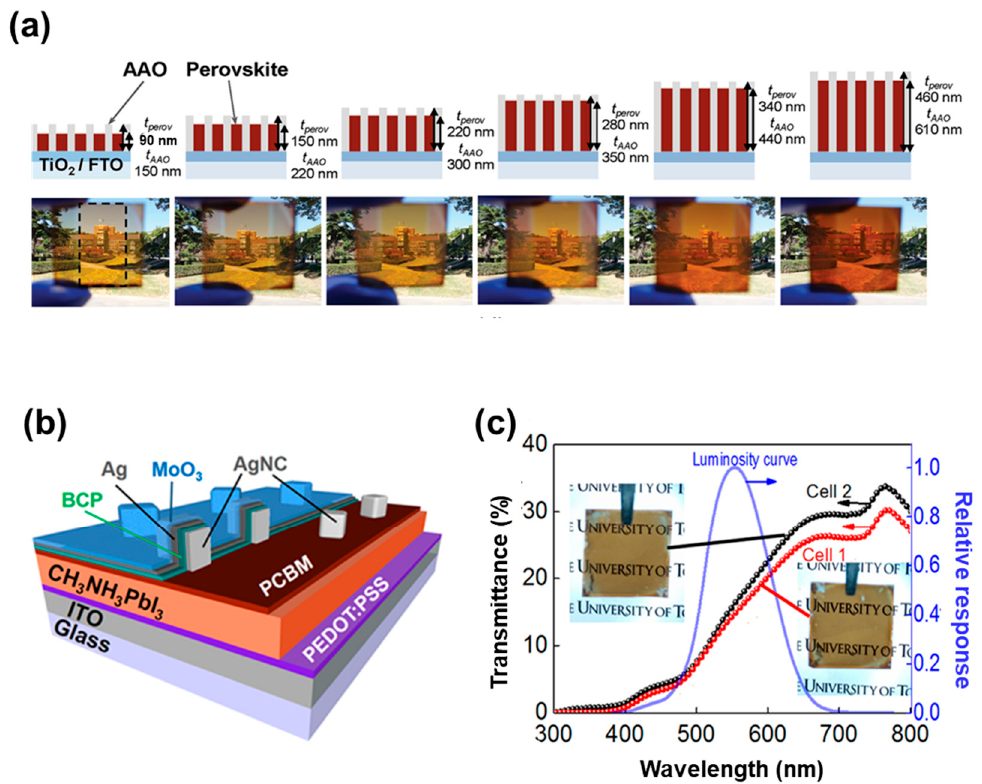
Figure 6. ( a ) Nanopillar-structured ST-PSC with different AAO templates and perovskite thicknesses. ( b ) Schematic representation of the device fabricated with Ag nanocubes. ( c ) Current–voltage spectra and transmittance spectra of plasmonic and non-plasmonic PVSCs together with the human luminosity curve. Reprinted with permission from Refs. [127,128].